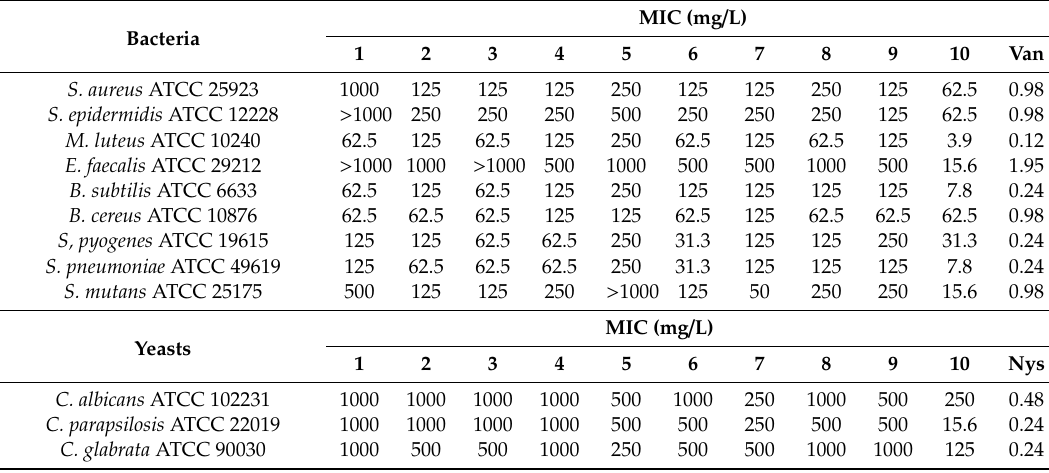
Table 6. The antibacterial and antifungal